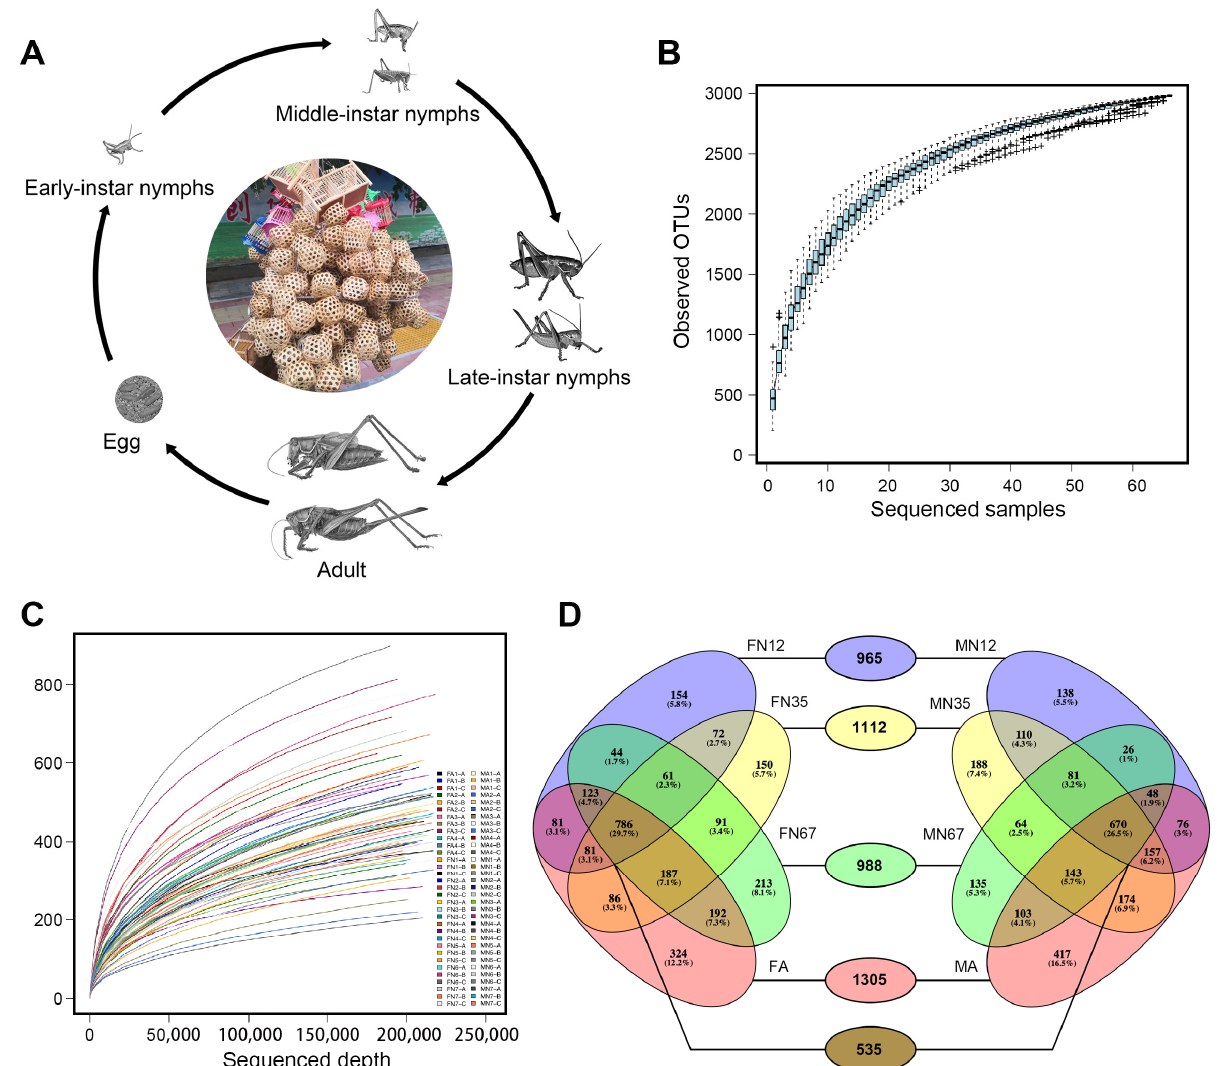
Figure 1. Changes in bacterial community diversity across life stages of Gampsocleis gratiosa . ( A ) Overview of development stages of Gampsocleis gratiosa , ( B ) species accumulation curves, ( C ) rarefaction analysis for each sample, ( D ) Venn diagram of OTU